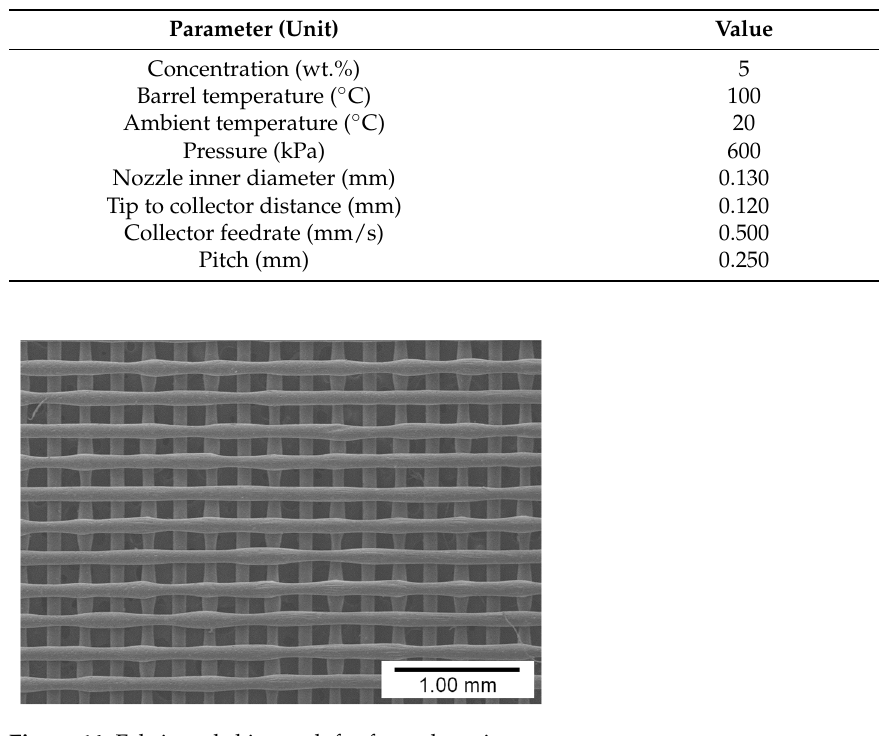
Figure 14. Fabricated skin patch for fever detection.